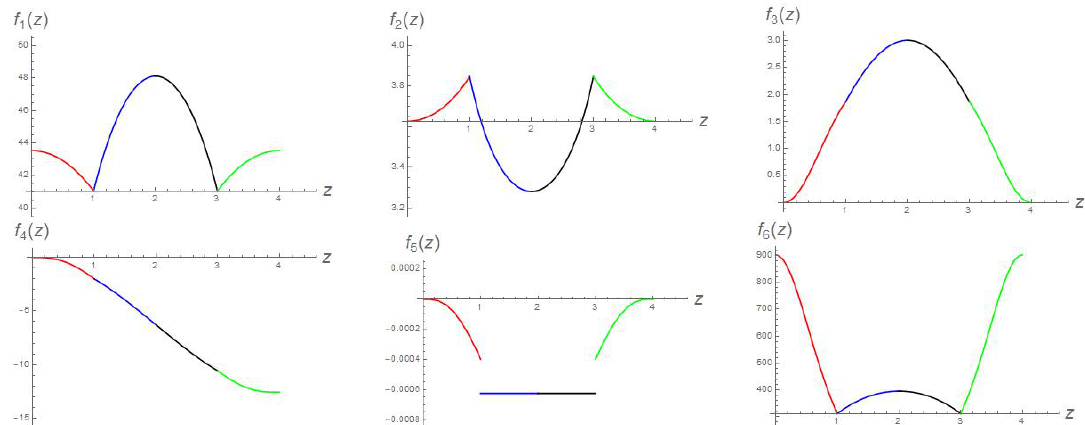
Figure 18. f i ( z ) for the dual background to the quiver in (cid:12)gure 6.